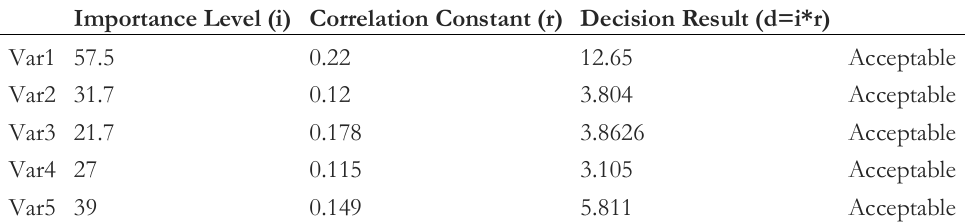
Table 14. Application of the Eq. (1) for each item.